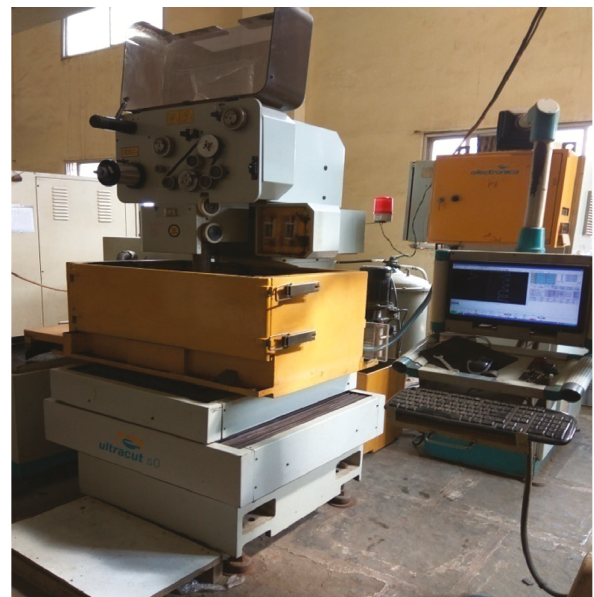
Figure 3: WEDM tool used for experimentation.